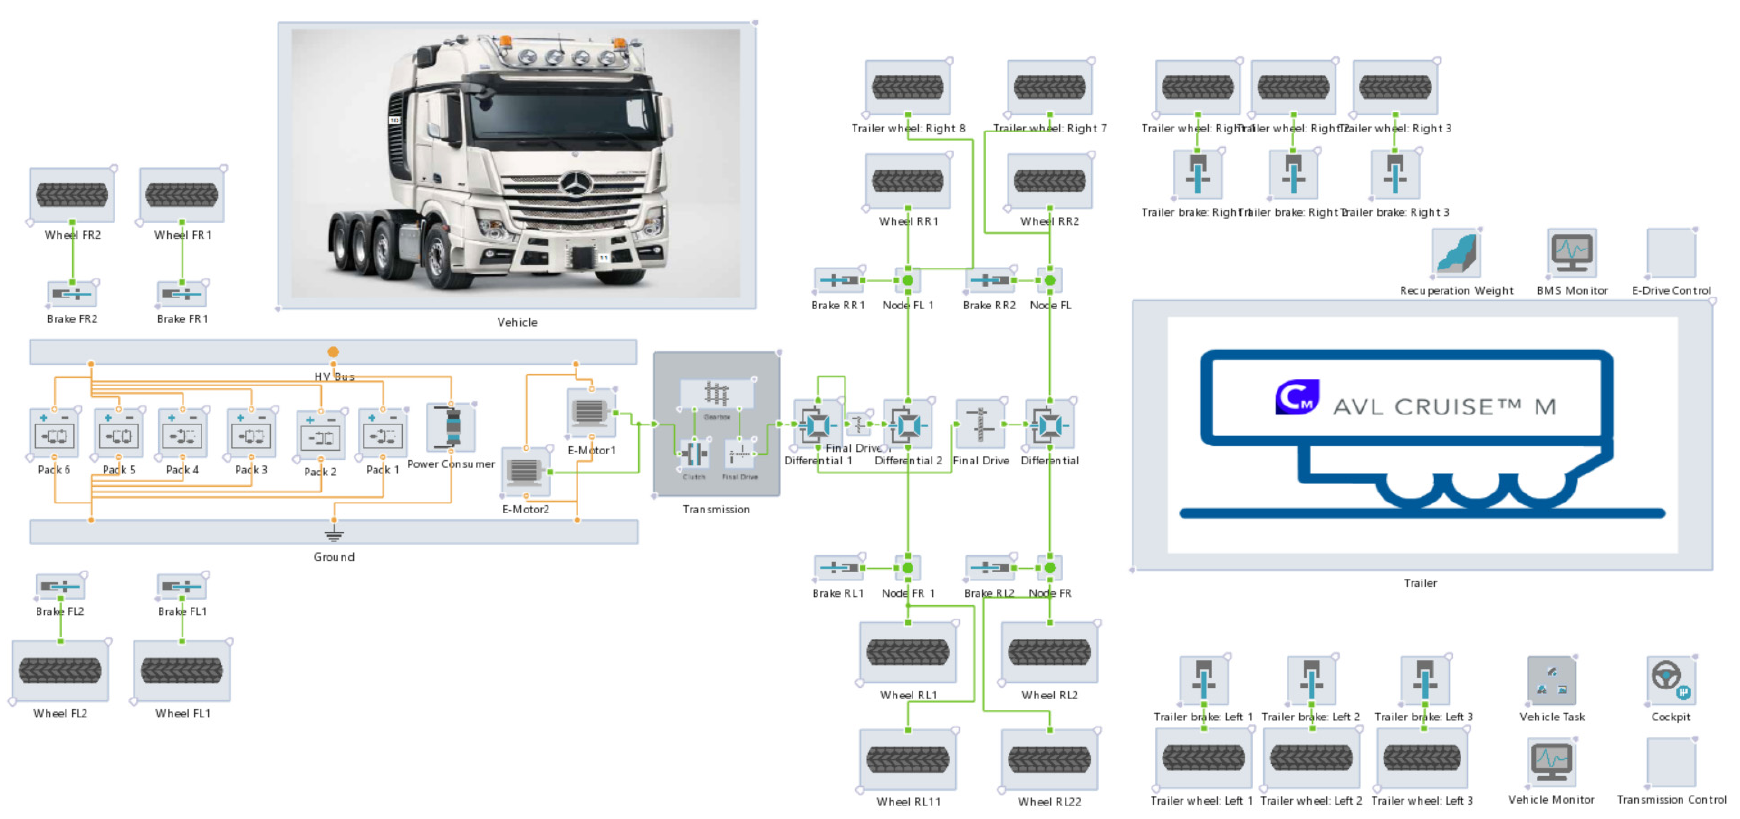
Figure 2. Block diagram for AVL vehicle model.